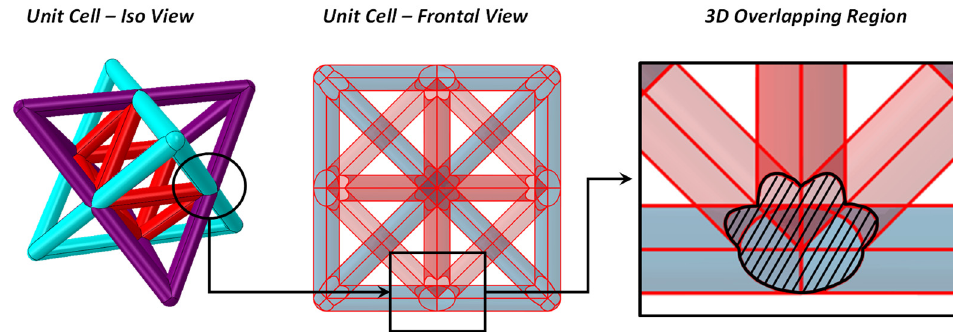
Figure 9. Overlapping region in 3D real unit cell.